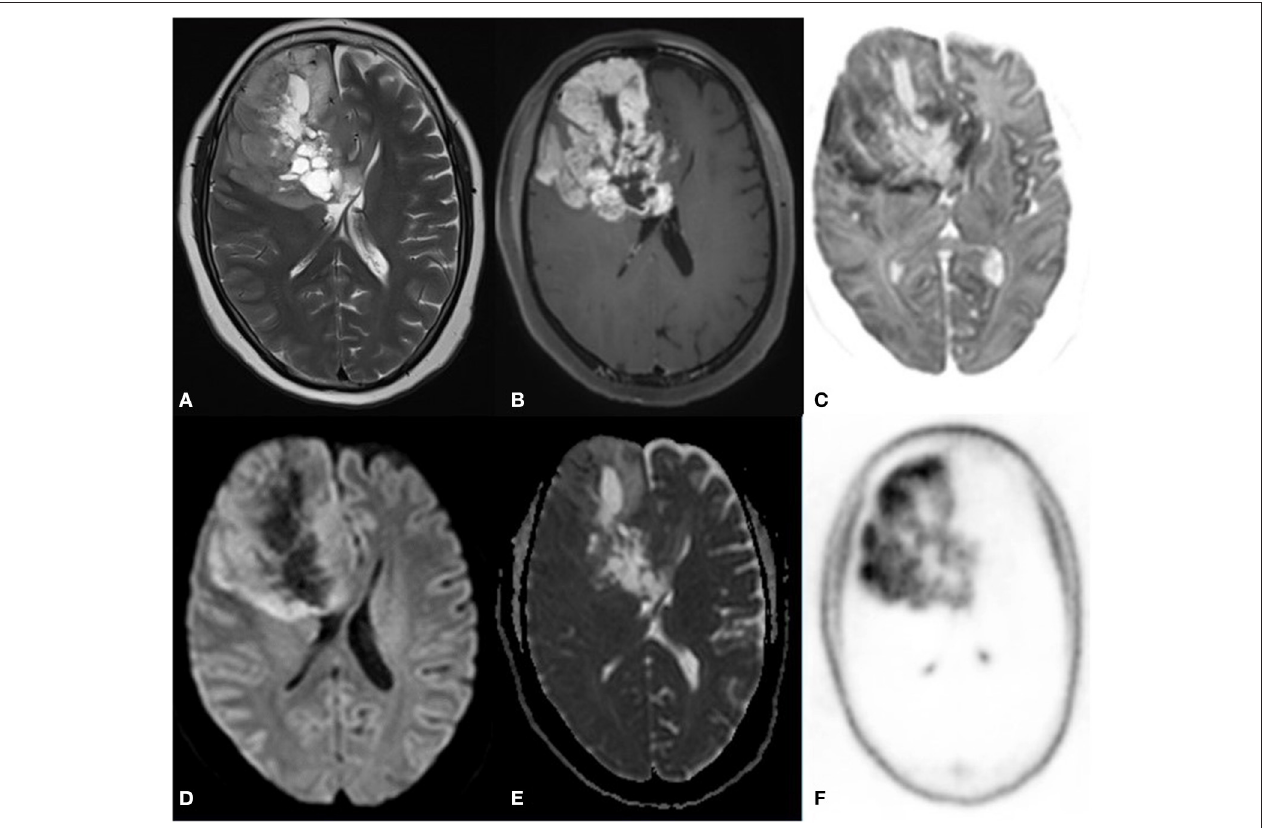
FIGURE 6 | A 52 year old female with a headache for 1 year with recent onset of a seizure. MRI PET (F18 CHOLINE) axial images T2W (A) post-contrast TW (B) Inverted DWI (C) DWI b2000 (D) ADC (E) NAC PET (F) shows Ill-defined infiltrative heterogeneous lesion in the right frontal lobe with invasion to corpus callosum showing intense heterogeneous enhancement. The lesion shows DWI restriction with hypermetabolism on PET. There is a match on the inverted DWI image and the NAC PET image, which is suggestive of